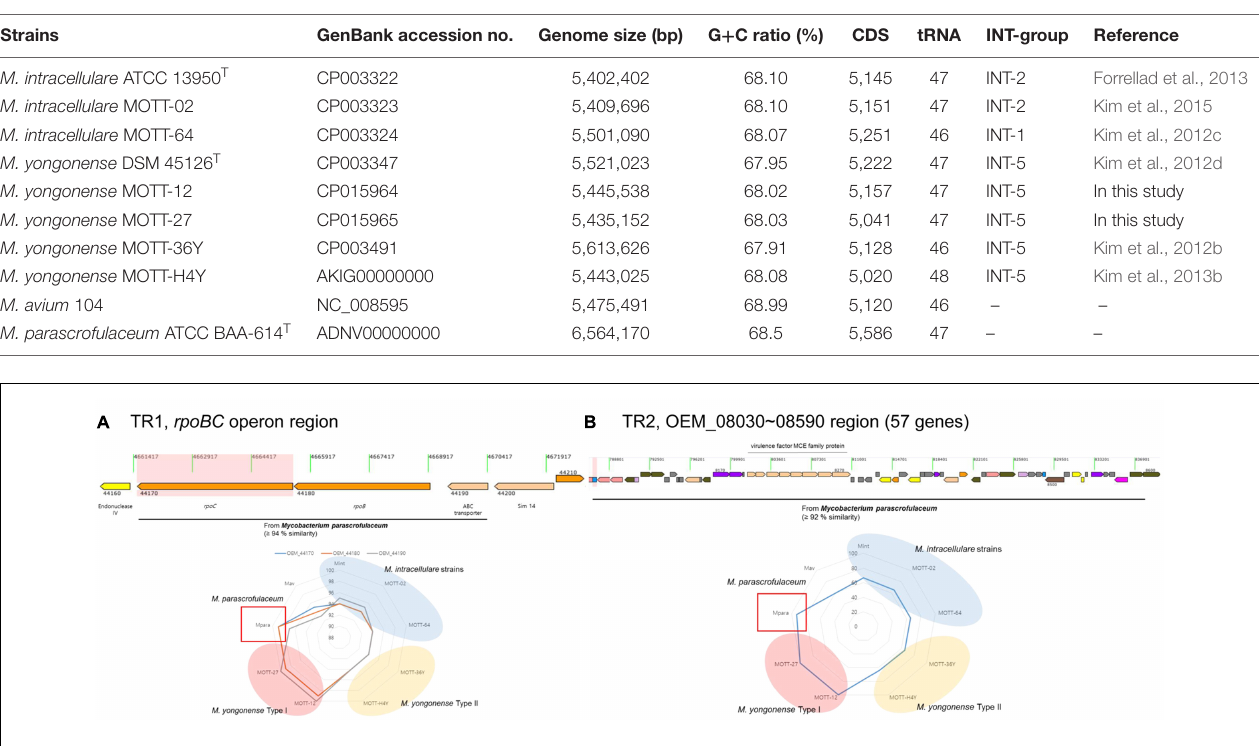
FIGURE 1 | Visualization of two putative lateral gene transferred regions within the M. yongonense DSM 45126 T genome. (A) First region ( rpoBC operon, OEM_44170 ∼ 44190) (TR1). (B) Second region (57 ORFs, OEM_08030 ∼ 08590) (TR2). Sequence similarities between M. yongonense DSM 45126 T and related strains were also visualized in each lower image. Red region, M. yongonense Type II strains; yellow region, M. yongonense Type I strains; blue region, M. intracellulare